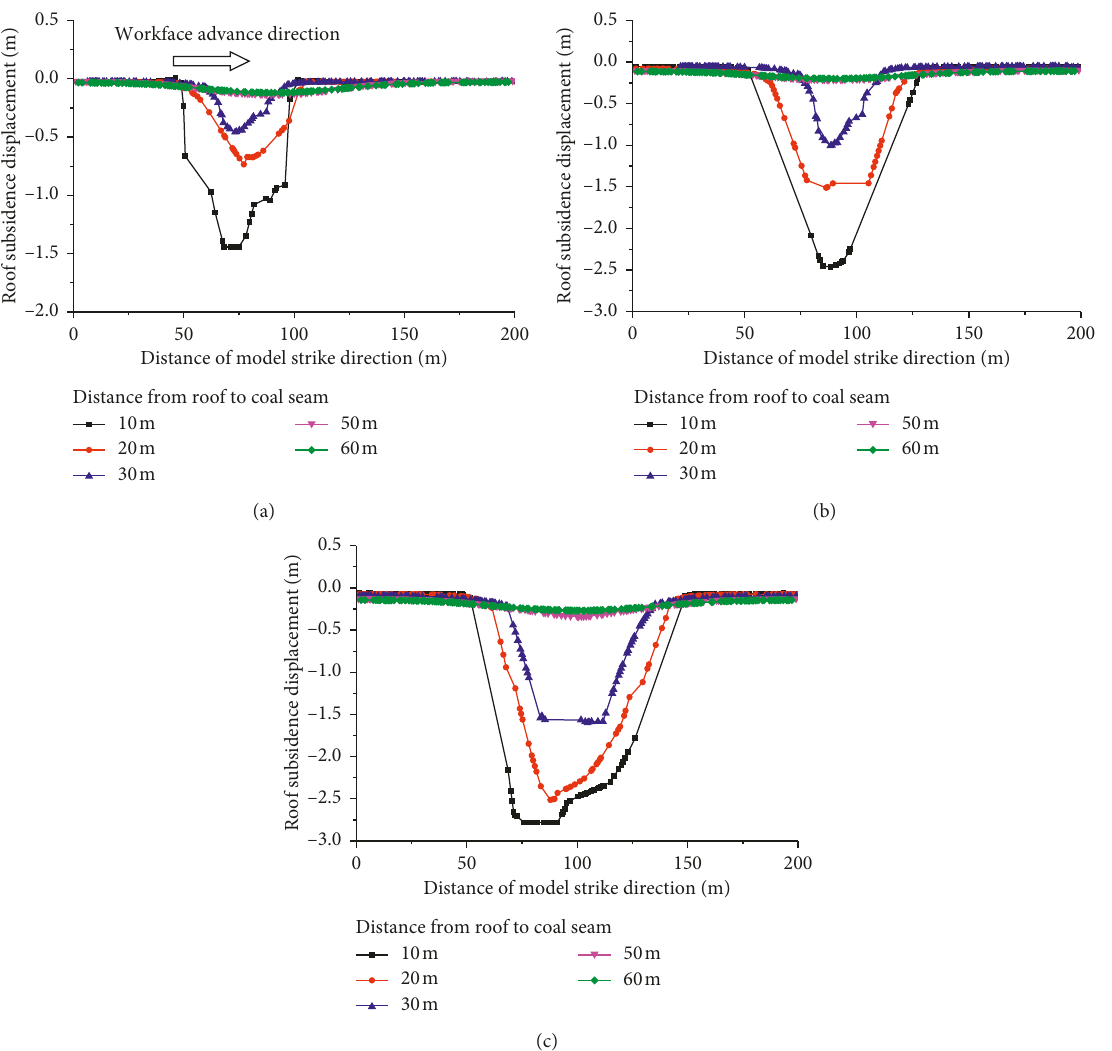
Figure 14: The subsidence displacement curves of different workface advance distances: (a) 50m; (b) 80m; (c) 100m.